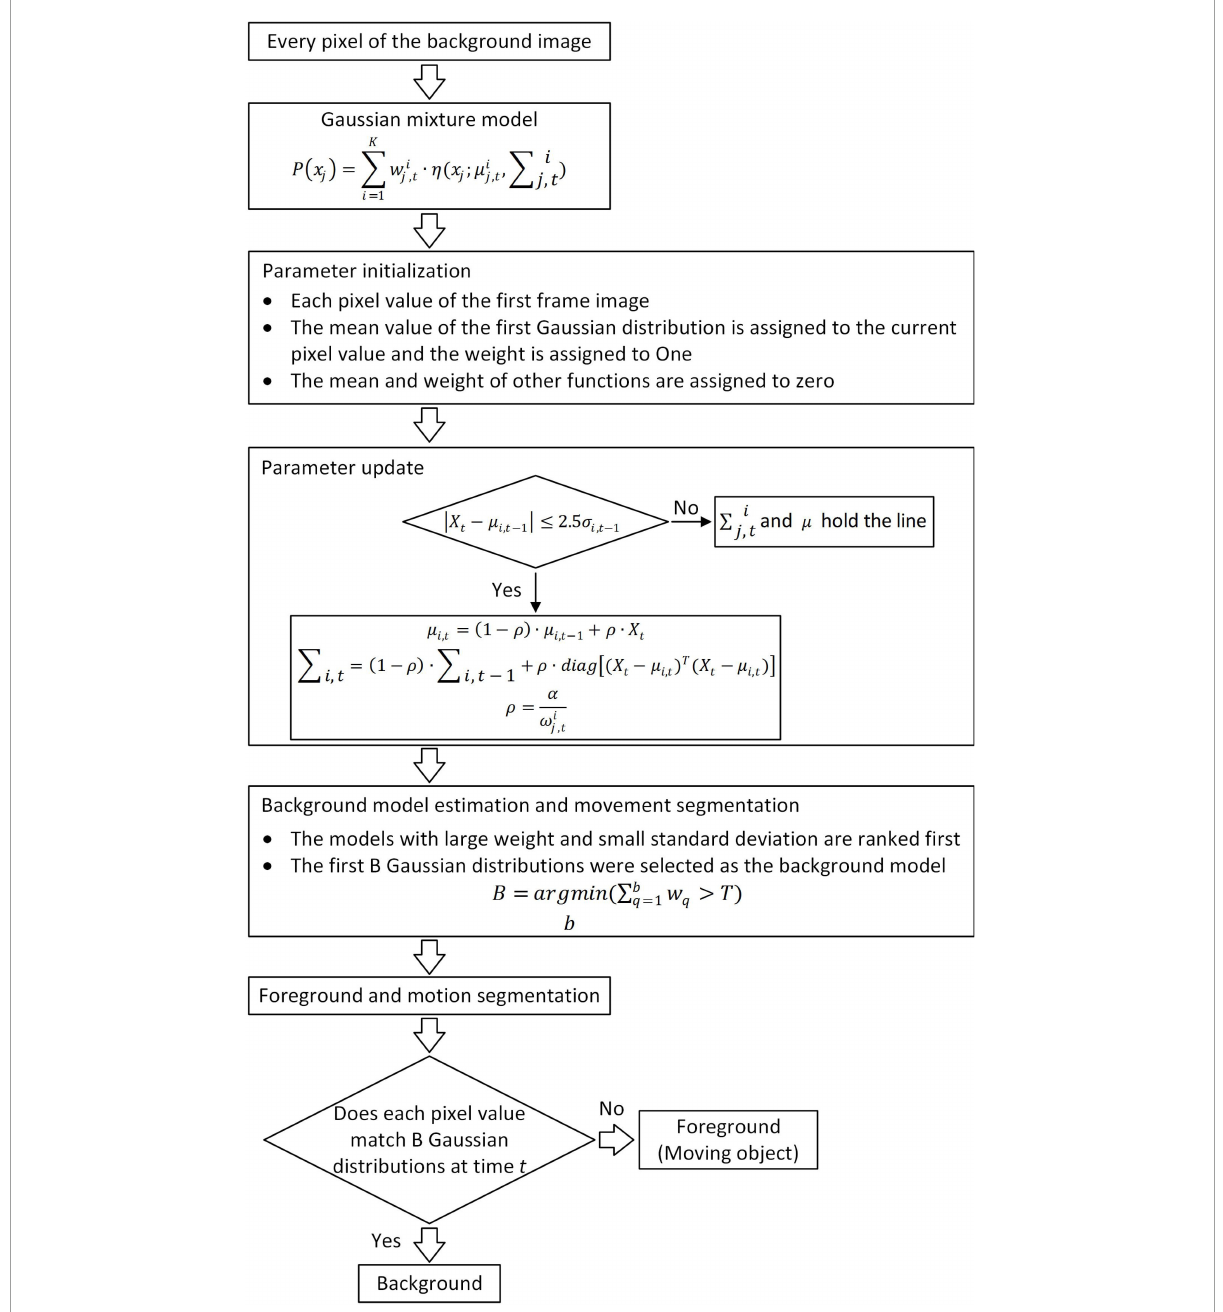
FIGURE2 Flowchart of the background subtraction